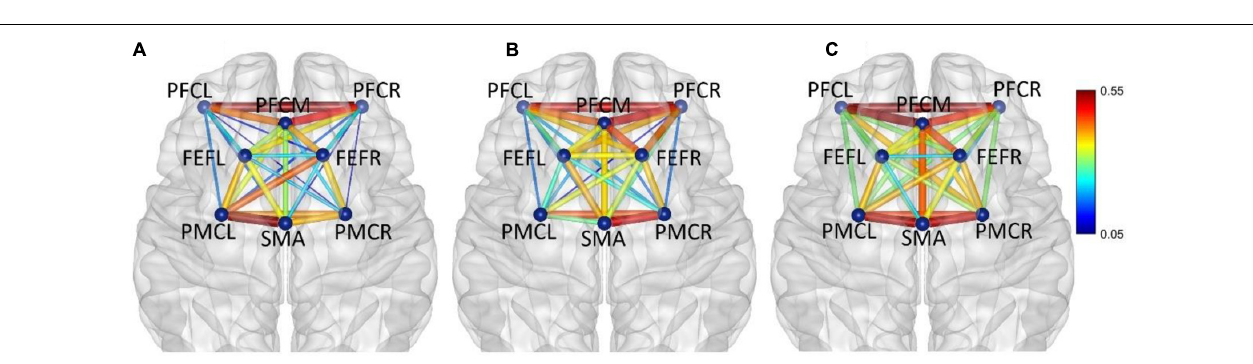
FIGURE 5 | Frequency band I (0.005–0.021 Hz), (A) non-fatigue, (B) moderate fatigue, and (C) severe fatigue. The average cortical functional connectivity network contains eight ROI brain regions. The width and color of the line represent the strength of the connectivity. Functional connectivity was visualized with the BrainNet Viewer (http://www.nitrc.org/project/bnv/).